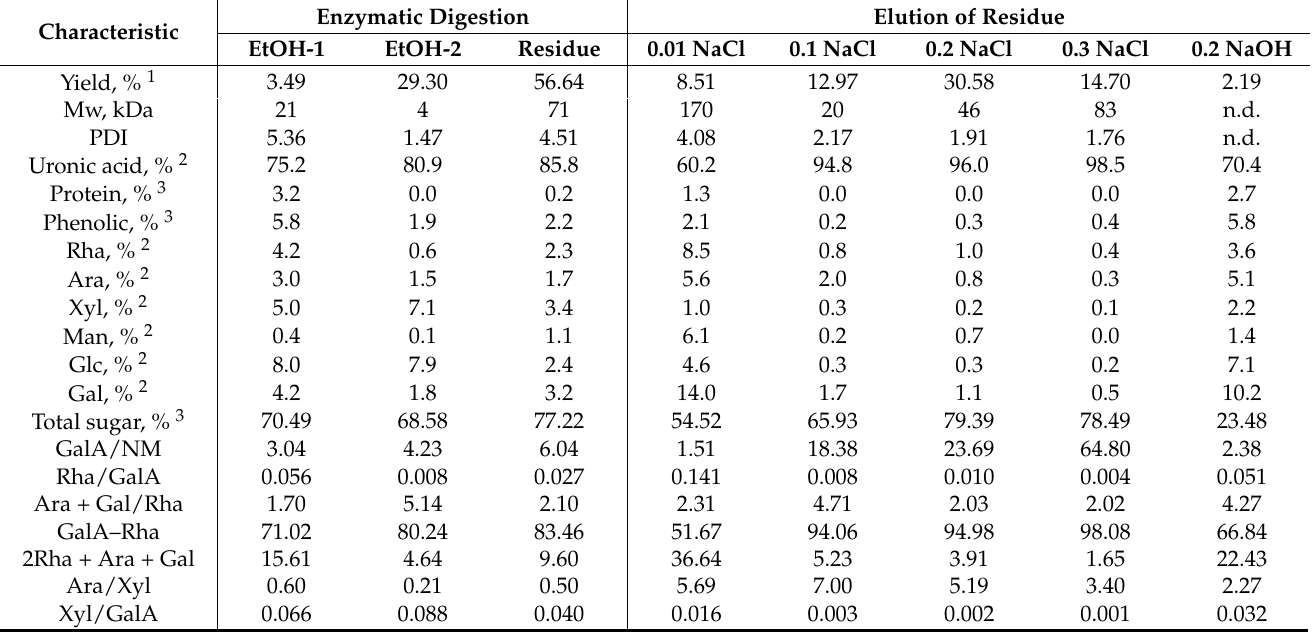
Table 4. Chemical characteristics of the polysaccharide fractions (1, 2 and residue) obtained by fractionated precipitation with ethanol of products of the enzymatic digestion of EA-0.8 and chemical characterization of the polysaccharide fractions obtained during fractionation of residue of enzymatic digestion on DEAE-cellulose column (OH − ).